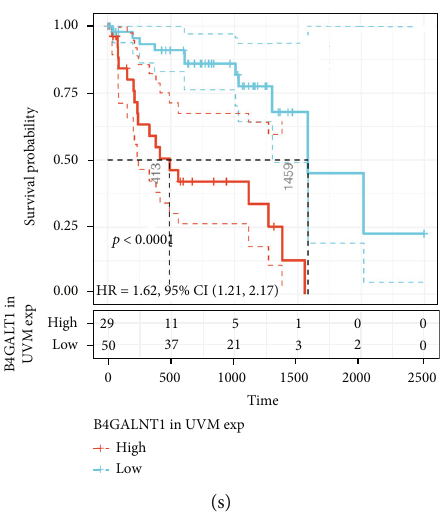
Figure 4: (a – l) Survival analysis of B4GALNT1 expression using Kaplan-Meier OS curves in ACC, BLCA, CHOL, HNSC, KICH, KIRP, LGG, LIHC, LUAD, MESO, UCEC, and UVM. (m – s) Survival analysis of B4GALNT1 expression using Kaplan-Meier PFI curves in ACC, BLCA, HNSC, KICH, LGG, MESO, and